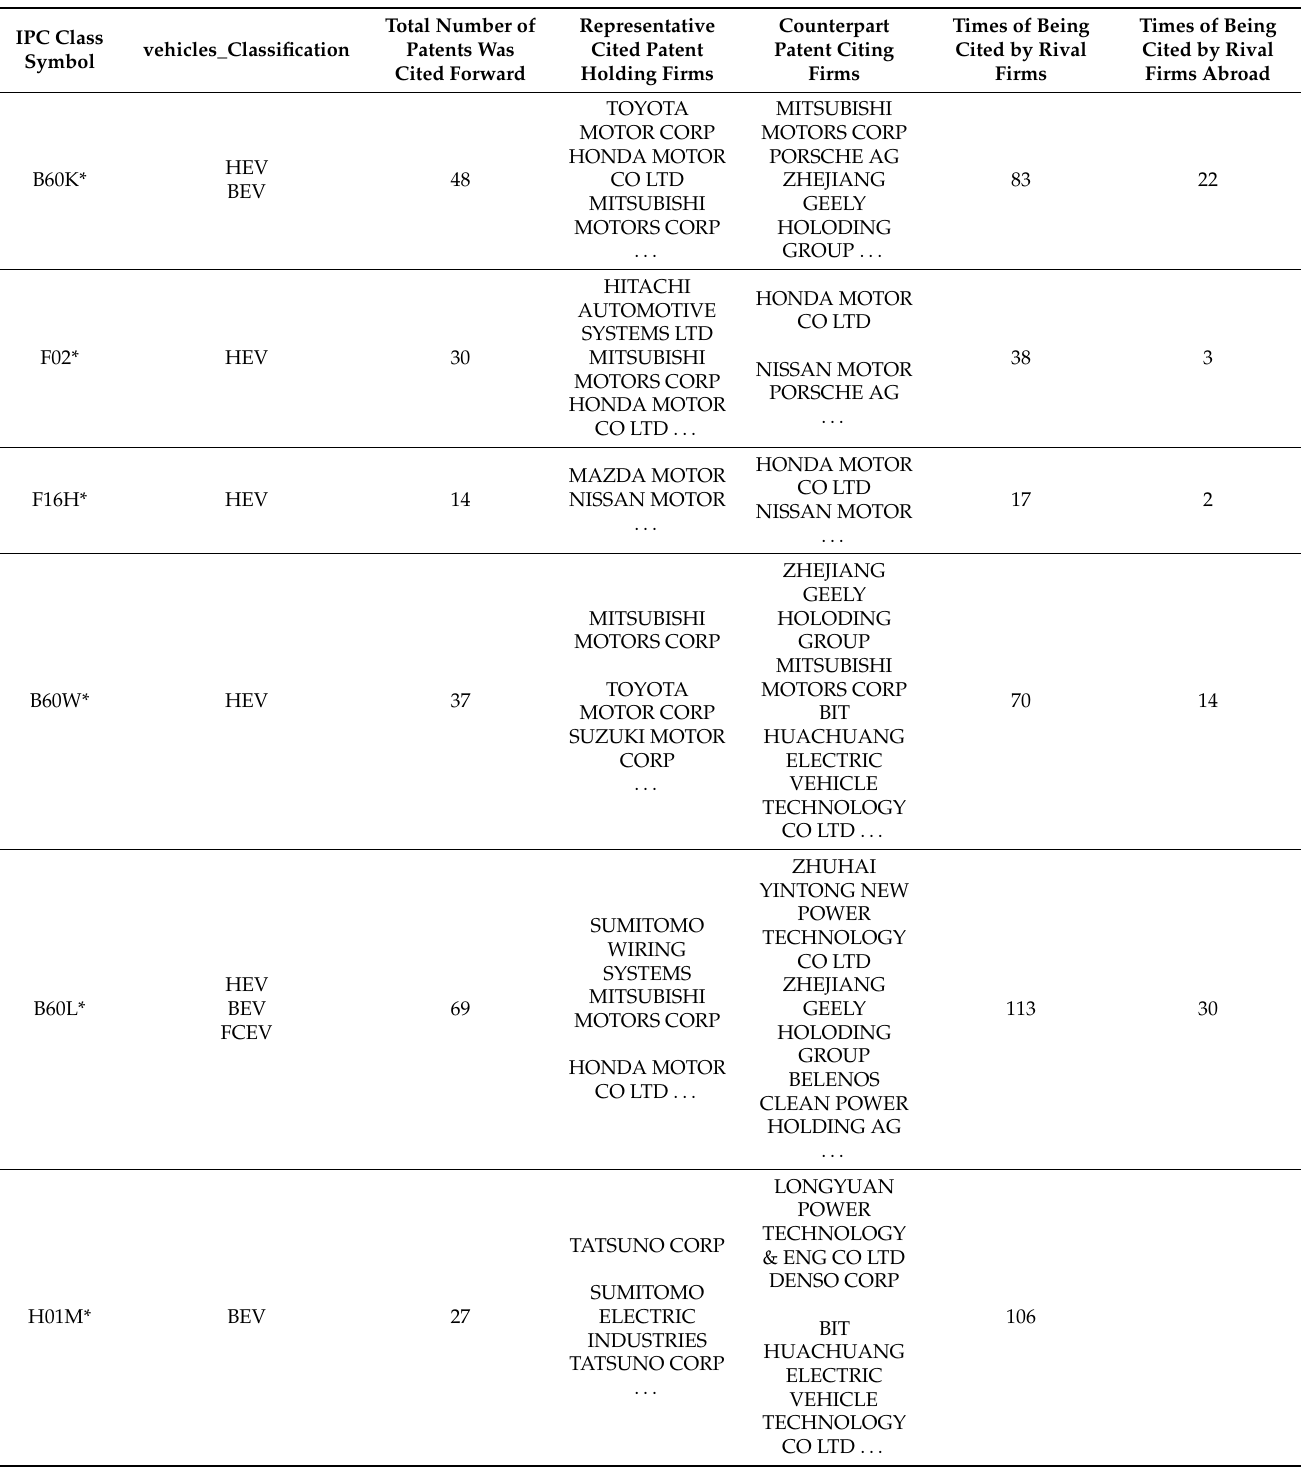
Table 2. Summary of study